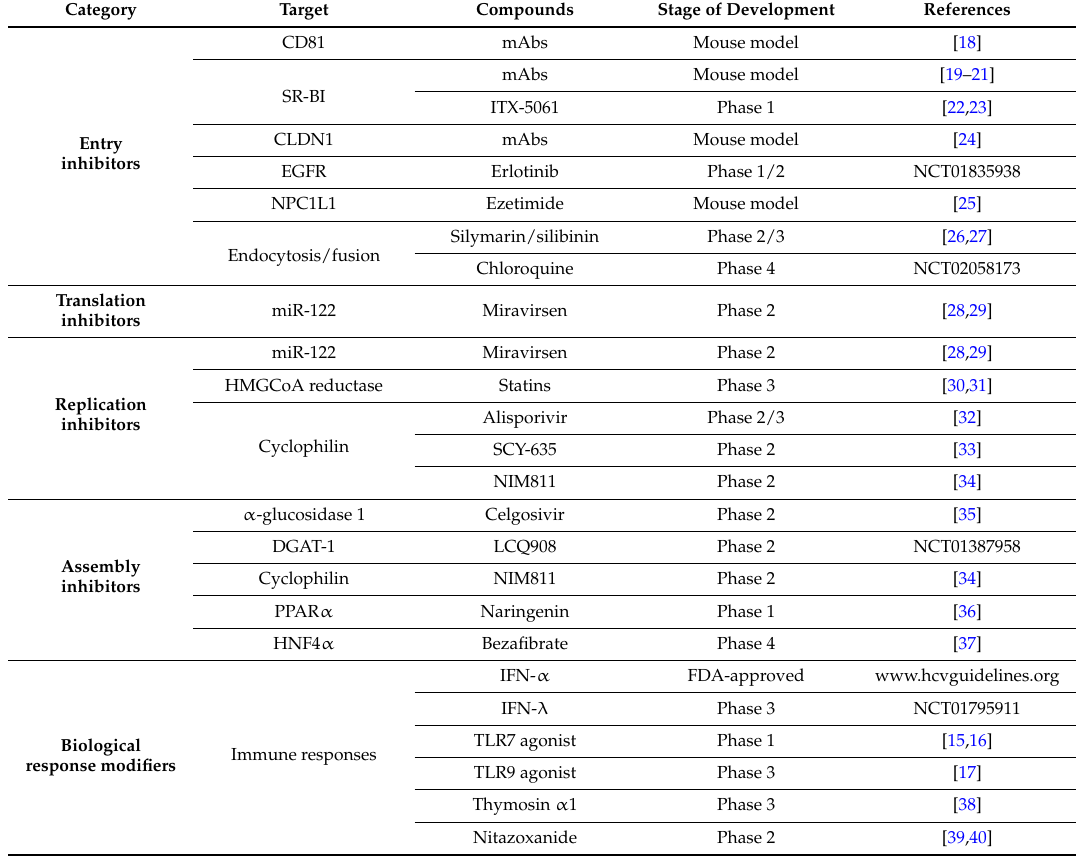
Table 1. Stage of development of host-targeting agents (HTAs) for prevention and/or treatment of HCV infection. Only HTAs having at least reached in vivo preclinical development are